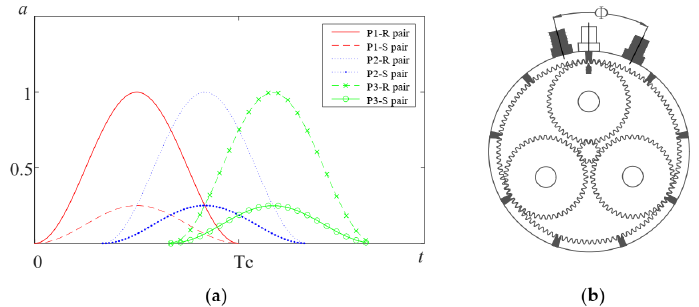
Figure 2. ( a ) Amplitude modulation by time-varying transfer path ( b ) Distribution of fixed fault meshing